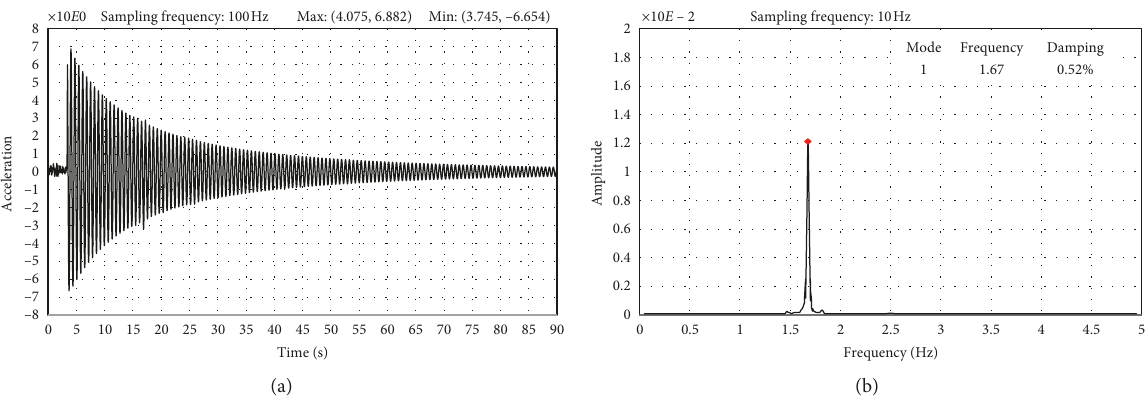
Figure 21: Monitoring results with the particle damper (7 alumina balls in container). (a) Acceleration-time history curve of the frame. (b) Identified frequency and damping ratio.